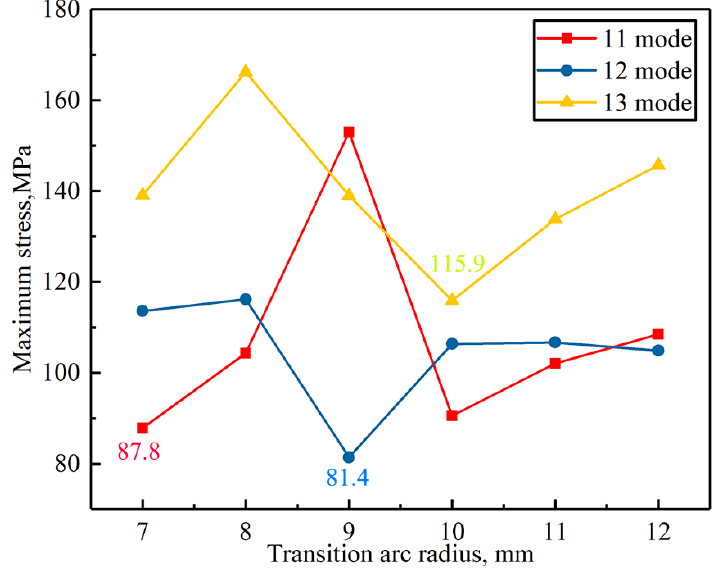
Figure 9. Relationship diagram between transition arc radius and maximum stress.